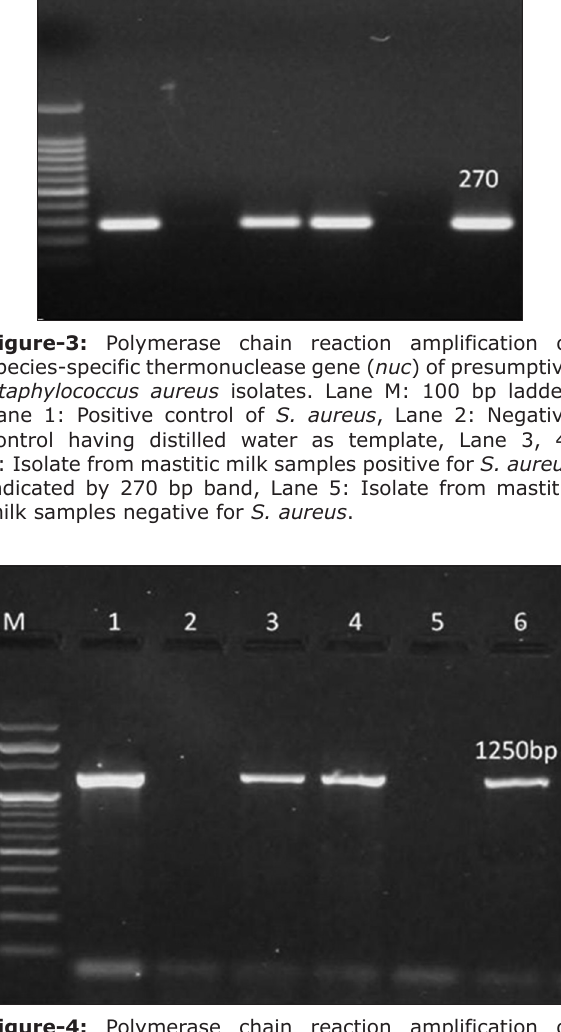
Figure-4: Polymerase chain reaction amplification of species-specific 23S rRNA gene ( staur ) of presumptive Staphylococcus aureus isolates. Lane M: 100 bp ladder, Lane 1: Positive control of S. aureus , Lane 2: Negative control having distilled water as template, Lane 3, 4, 6: Isolate from mastitic milk samples positive for S. aureus indicated by 270 bp band, Lane 5: Isolate from mastitic milk samples negative for S. aureus